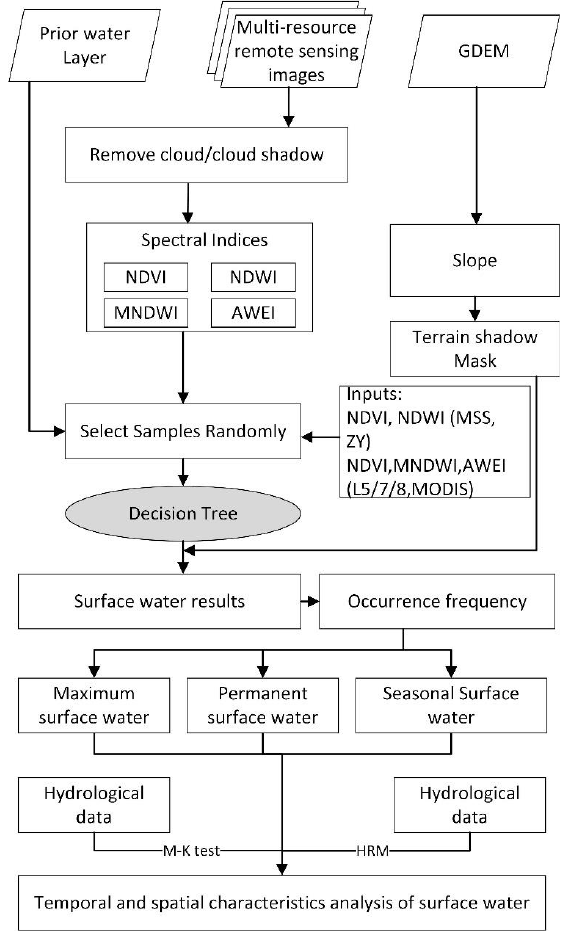
Figure 2. Flow chart of surface water change analysis based on multisource remote sensing im- ages.